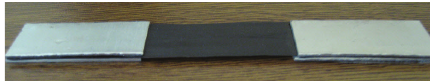
Figure 10: Tensile test specimen for carbon/epoxy composite.